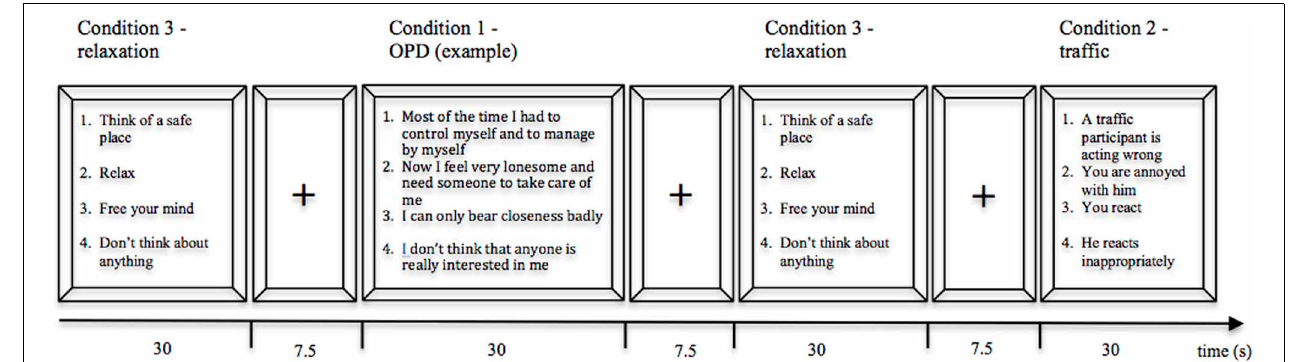
FIGURE 3 | Block-design for OPD stimulus presentation. Each of the 4 sentences of a condition was presented for 7.5s in a fixed order 1–4.